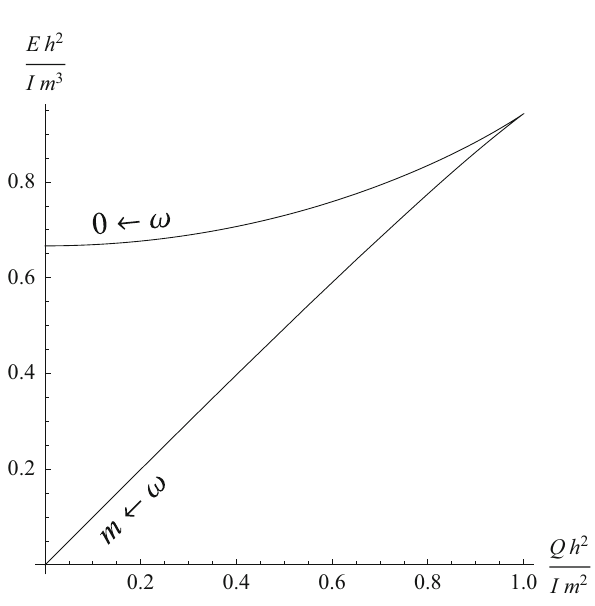
Fig. 1 Numerical solution for the fields F ( R ) and G ( R ) [9]